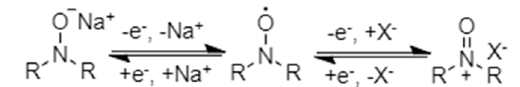
Figure 8. Molecular structures of two non-conjugated conductive radical polymers.